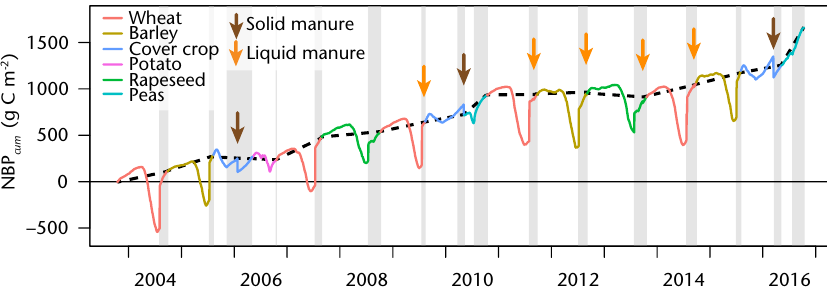
Figure 2. Daily cumulative net biome production (NBP cum ) between 16 October 2003 and 11 October 2016. The black dashed line connects NBP cum at the end of each crop season. During time periods with a grey background, the field was bare (from harvest of a crop to sowing of the next crop or from first ploughing after sowing of a crop to sowing of the next crop if the first crop was not harvested).